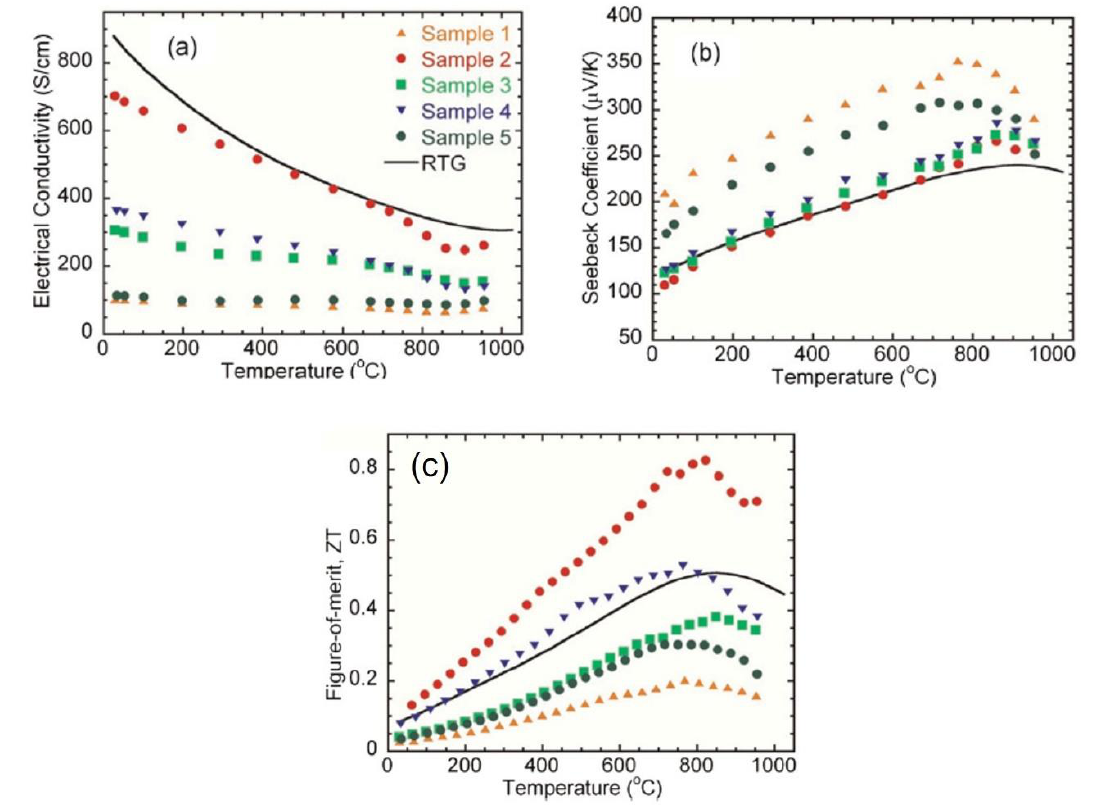
Figure 6. Thermoelectric properties of nanostructured SiGe alloys ate different preparation conditions as a function of temperature. ( a ) The electrical conductivity for 5 samples and RTG sample, ( b ) The seebeck coefficient for the same 5 samples and RTG one, and ( c ) ZT values, Reprint with per-